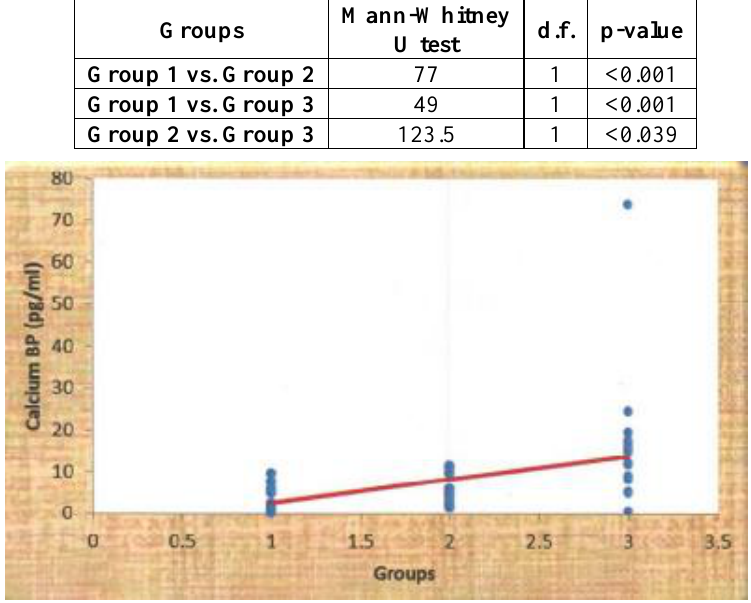
Fig.1: Comparison of Median values of Calcium BP among the three studied groups Table 2: Statistical differences among the study groups